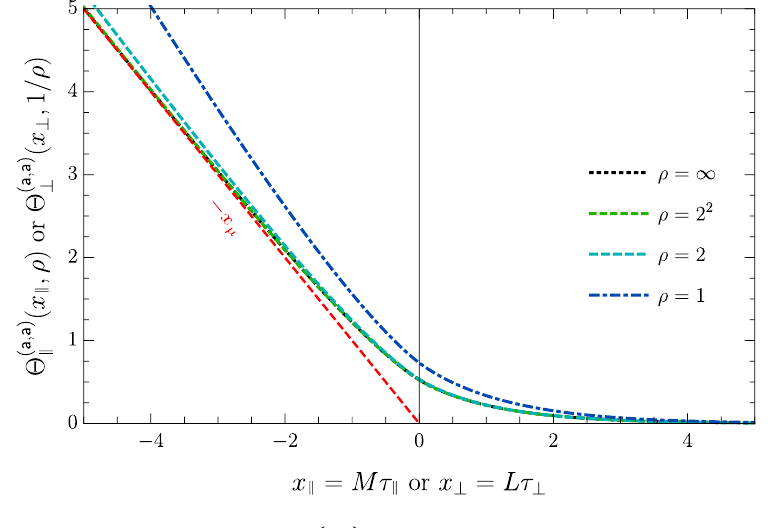
( a , a ) ( x ρ ) for different values for the as- Figure 8: Scaling function Θ δ , δ pect ratio ρ . Due to the antiperiodic BCs the system has the symmetry ( x /ρ ) . For negative values of x ( x ρ ) = Θ ( a , a ) Θ ( a , a ) ⊥ ,1 δ the scaling function di- (cid:107) , ⊥ (cid:107) verges linearly, marked as red (dark) dashed line. The scaling function converges very fast to its limiting form at ρ = ∞ , while its biggest contribution is at ρ = 1 as there the domain wall lies diagonal in the system and is thus longest compared to the two length scales L and M